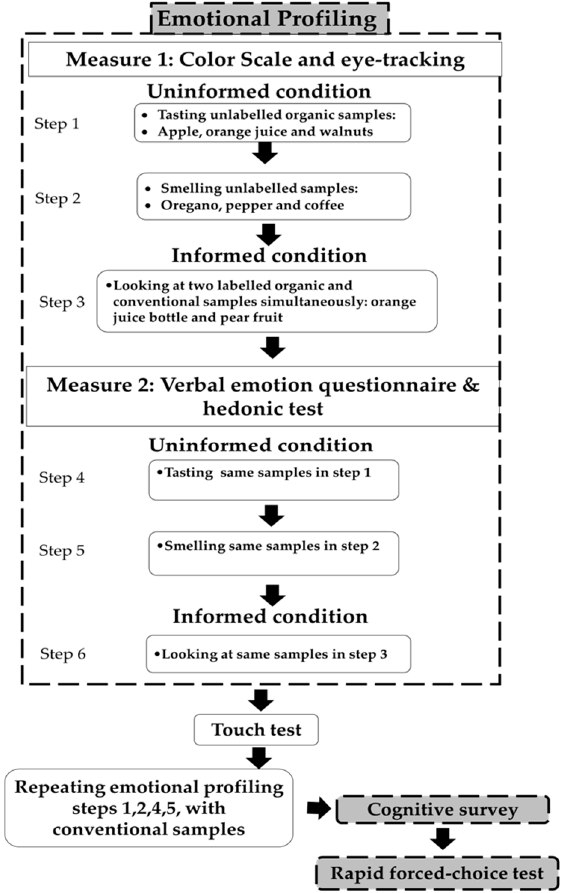
Figure 1. Experimental design that demonstrates the procedures of informed, uninformed emotional profiling, touch test, cognitive survey, and the rapid forced-choice